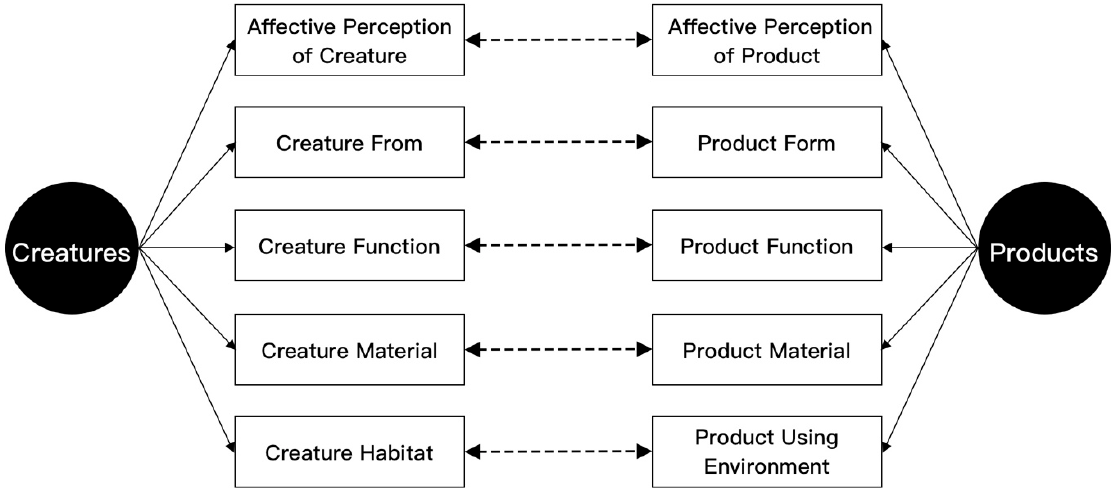
Figure 2. Bionic mapping relationship between creatures and products.